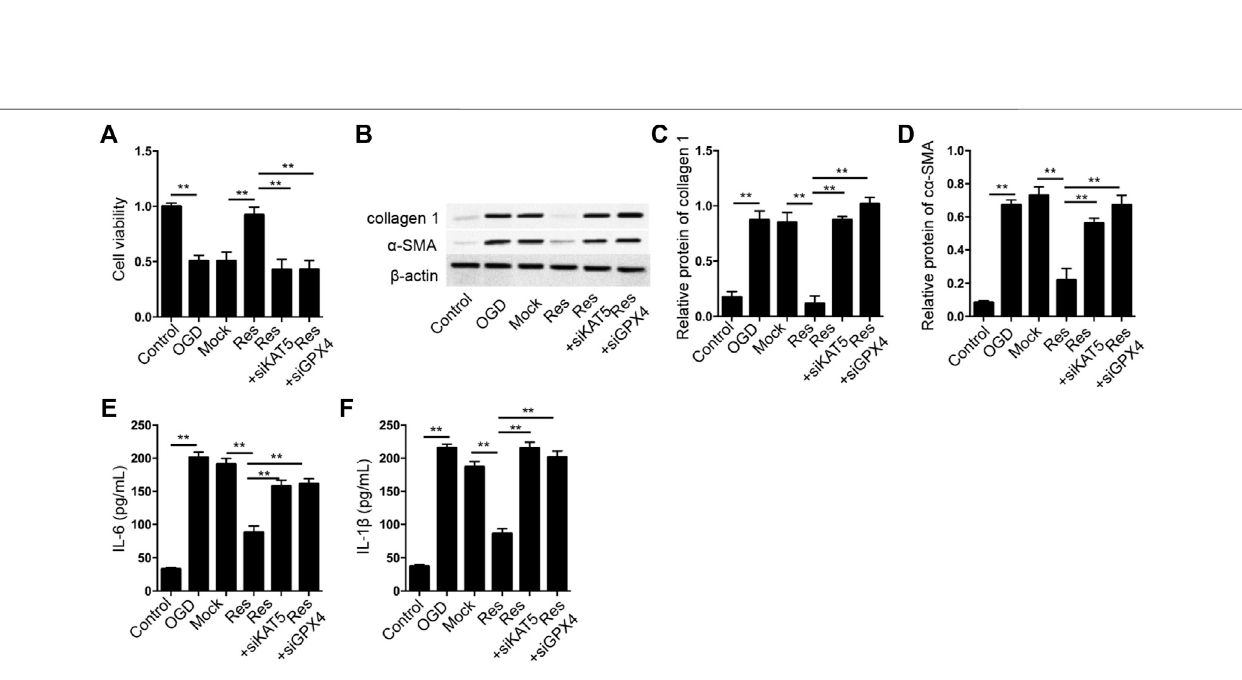
Frontiers in Pharmacology |